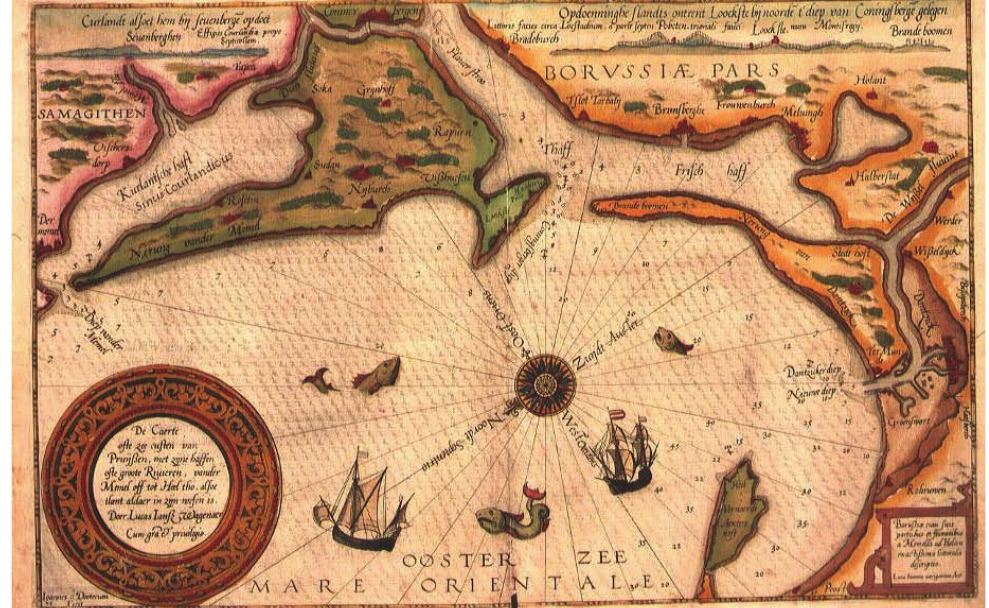
Fig. 4. 1589 L. j. Waghener Prussian coastal navigation chart (VilniusUniversity Lelevel gift